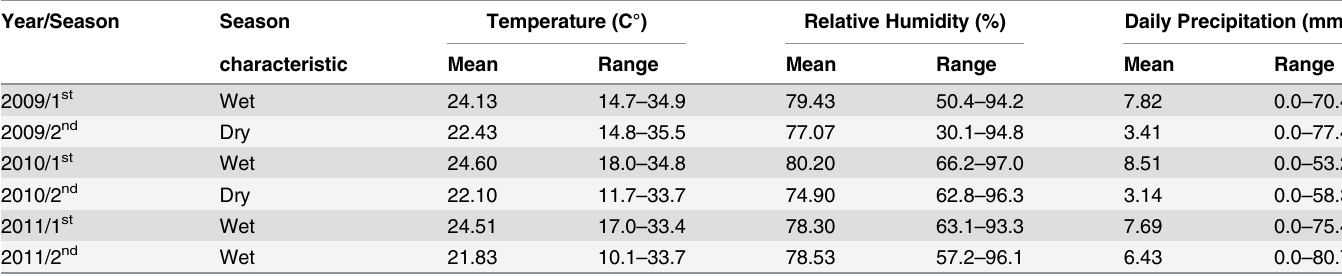
Table 1. Weather conditions during six maize growing seasons in Jaboticabal, S ã o Paulo, Brazil.